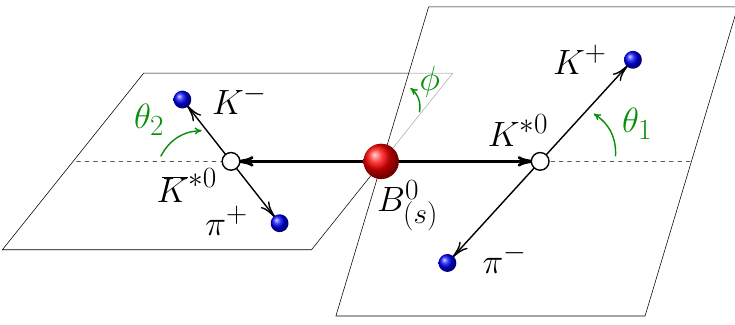
Figure 2 . Definition of the helicity angles, employed in the angular analysis of the B 0 decays. Each angle is defined in the rest frame of the decaying